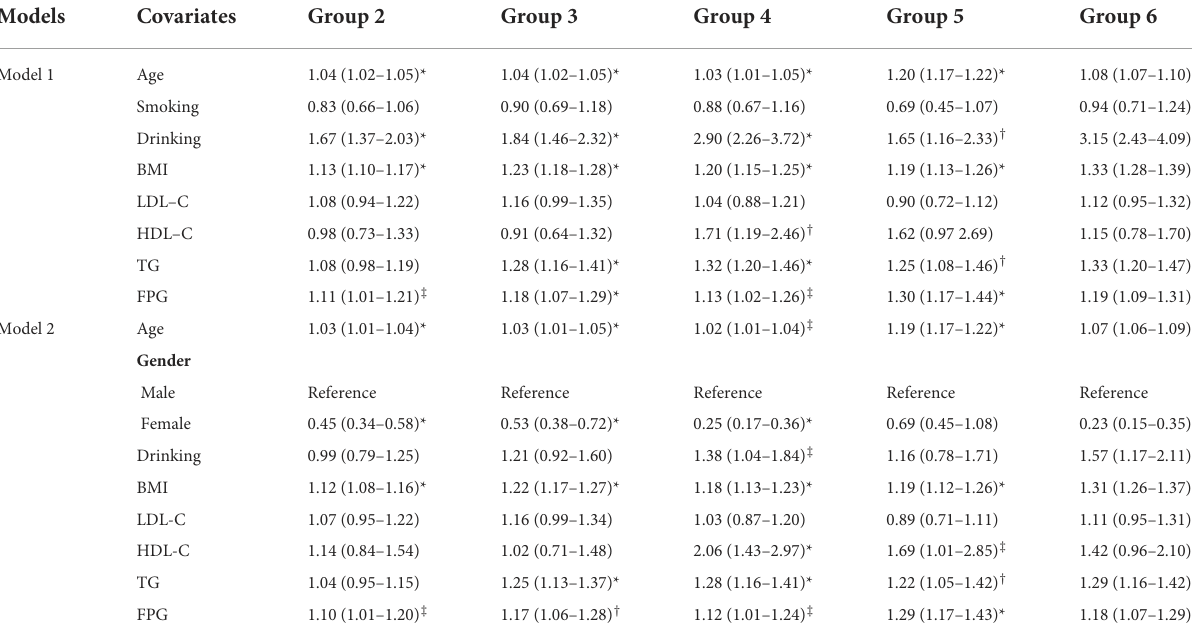
TABLE 5 ORs and 95% CIs of multiple covariates on multi-trajectories with trajectory group 1 as reference.